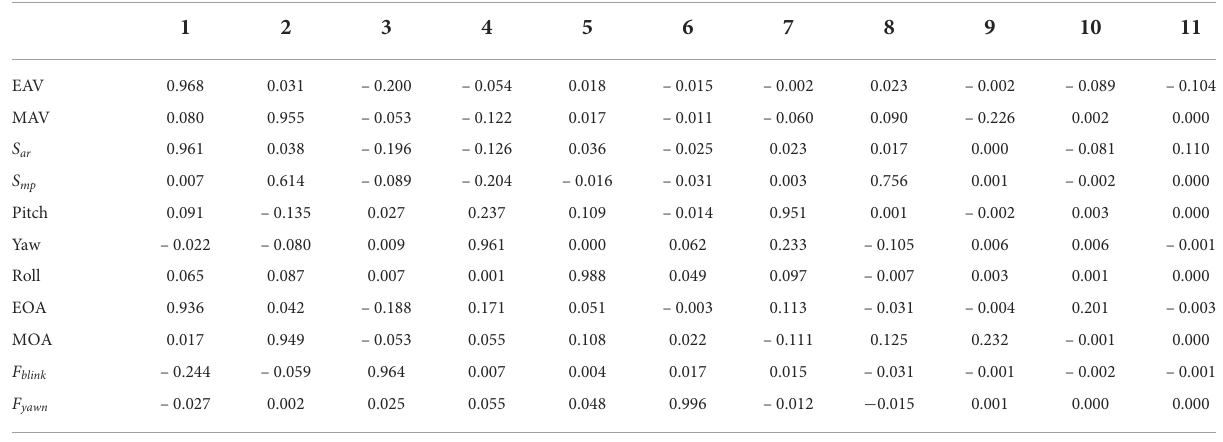
TABLE 2 Loadings matrix of rotated factor.